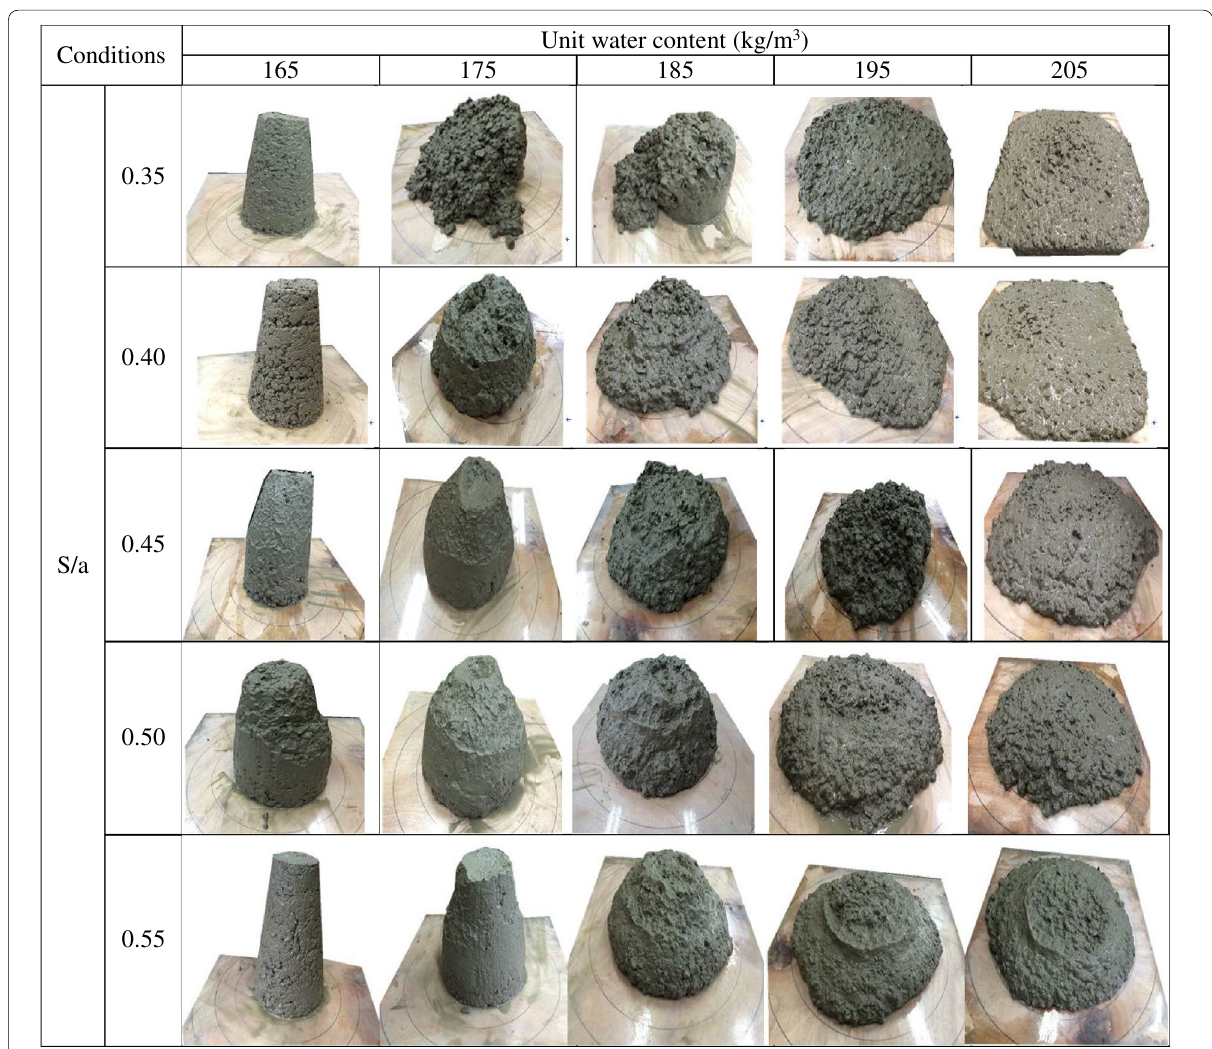
Fig. 6 Shapes of the slumping concrete after slump test for normal concrete